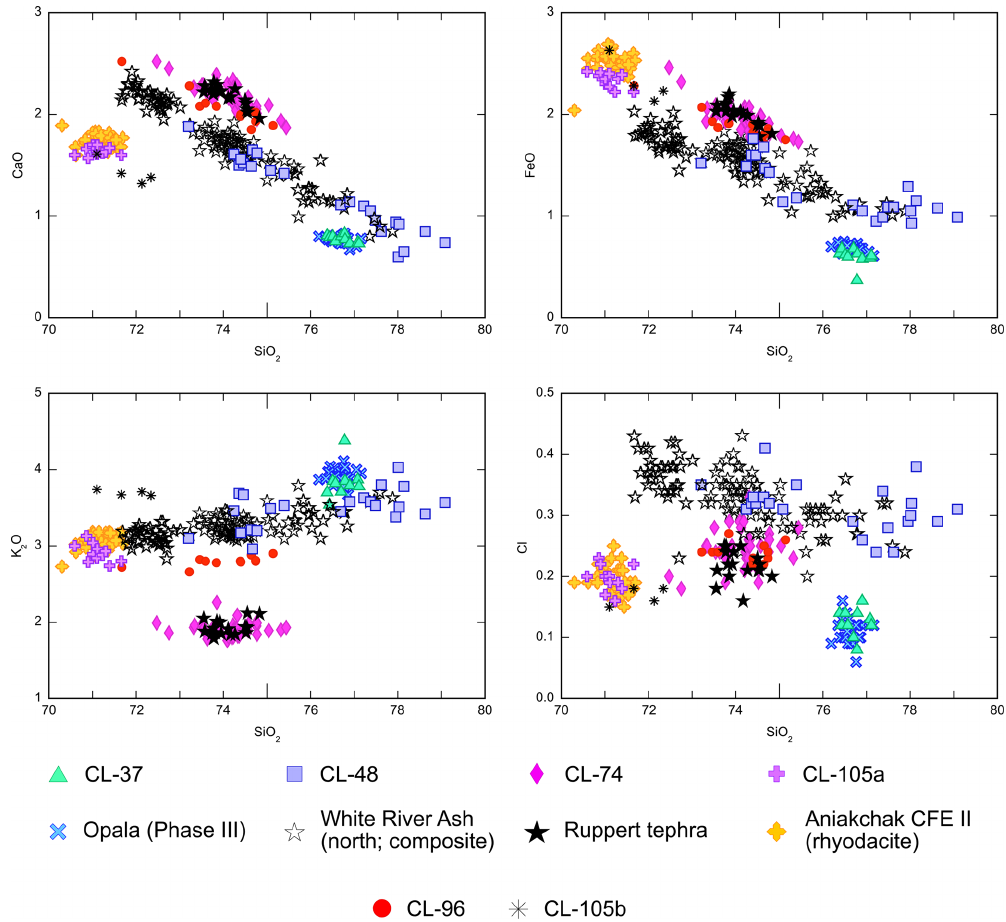
Figure 3. Geochemical biplots showing major-element data for the five unique populations of cryptotephra glass identified from Cascade Lake sediment and data for reference material where relevant. Points for CL-105b are also plotted, for reference. See Table 2 for sample details and Table S2 for individual point